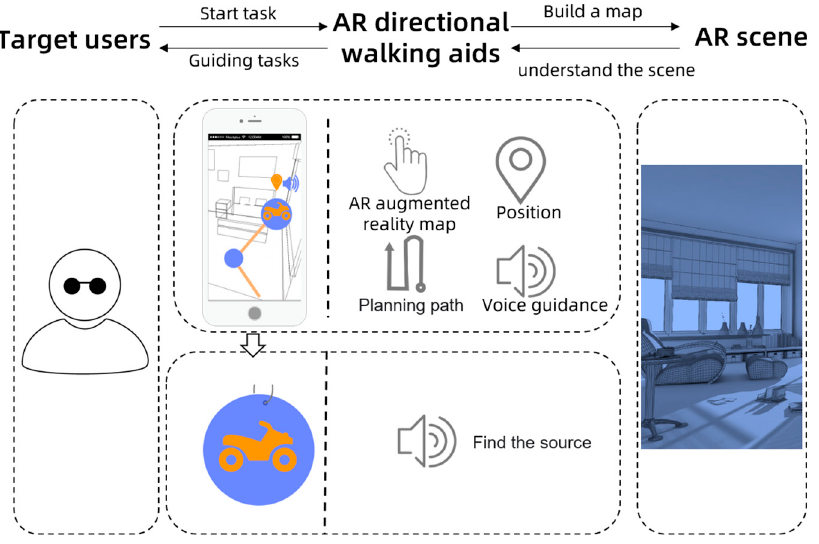
Figure 2. The design concept of the orientation walking aids.